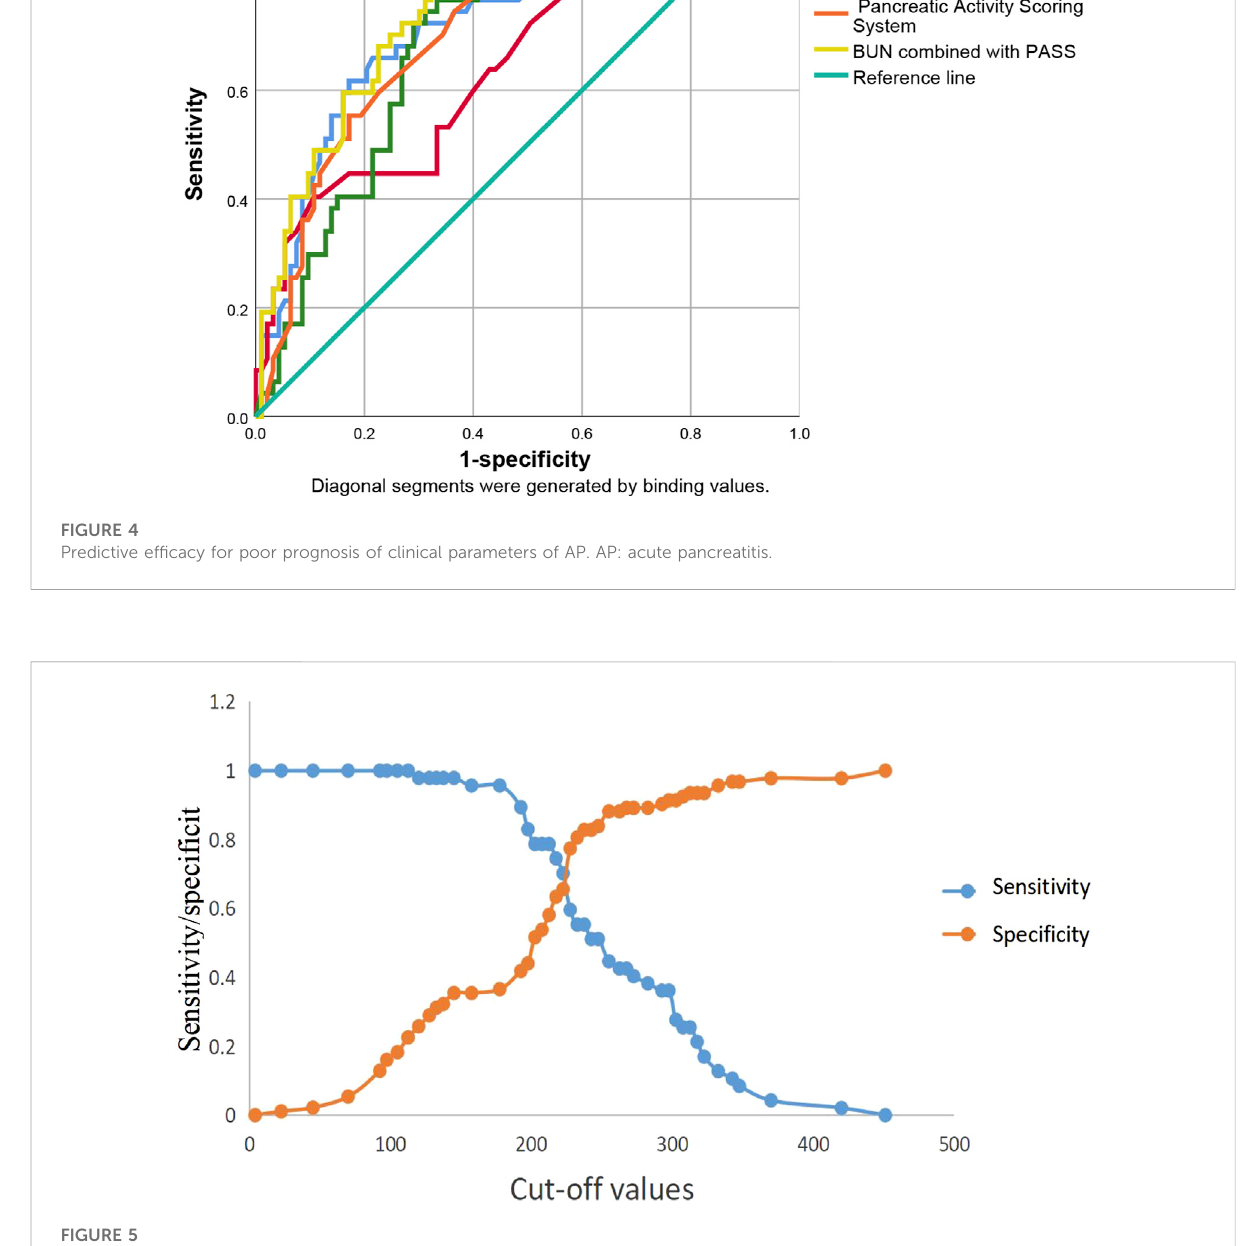
FIGURE 5 Sensitivity and speci fi city curves of PASS scores in poor prognosis prediction in the presence of different cut-off values. PASS: pancreatitis activity scoring